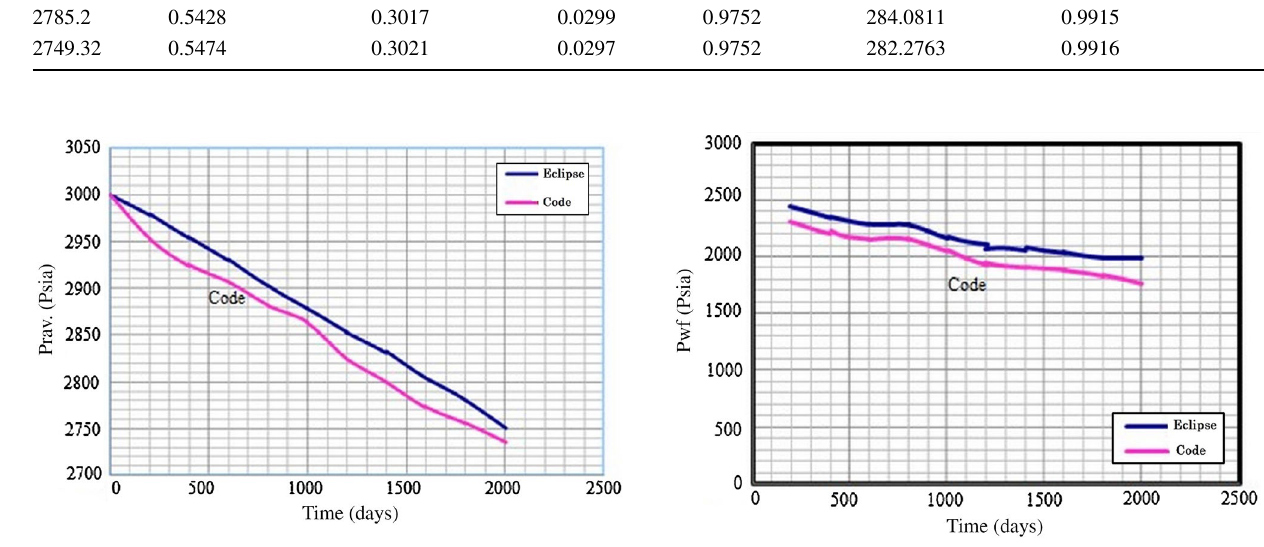
Fig. 6 Average reservoir pressure versus time of case #1